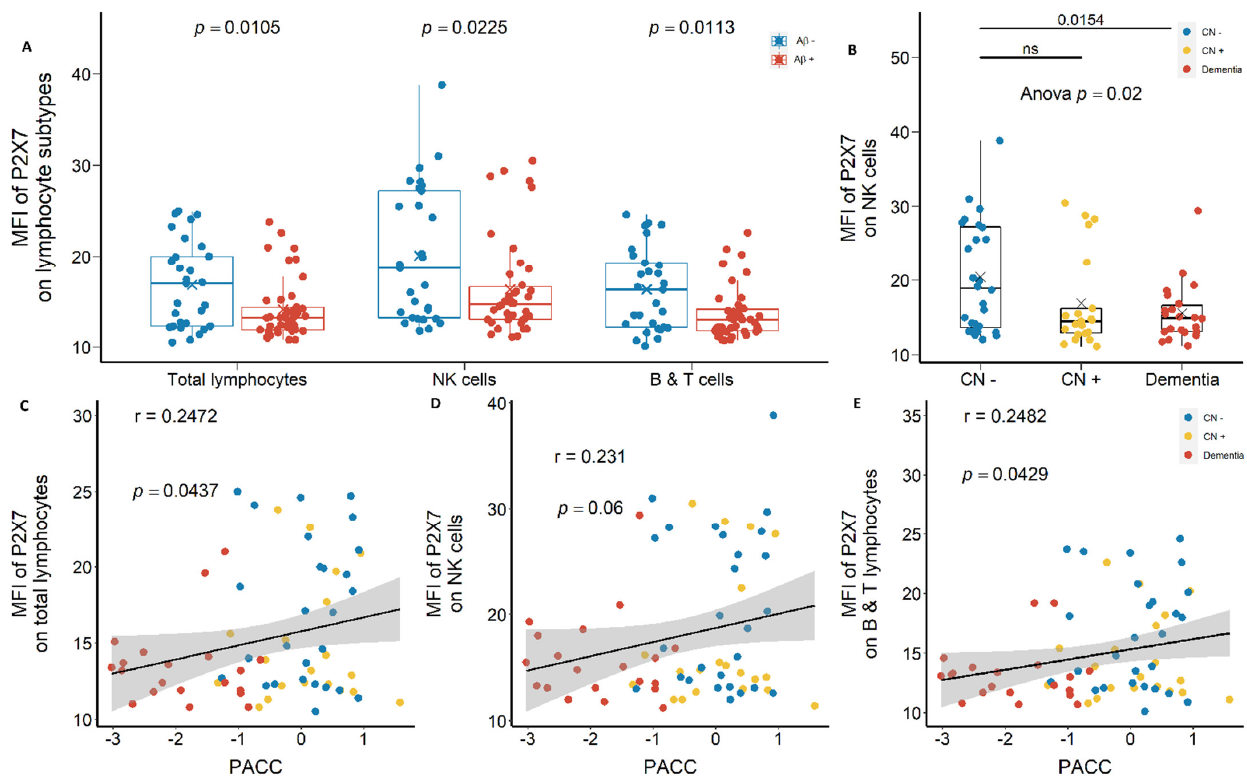
Figure 4. P2X7 expressions on lymphocytes in the discovery cohort. ( A ) P2X7 expressions on total lymphocytes ( left ), CD14 − CD16 + NK cells ( middle ), and CD14 − CD16 − B and T lymphocytes ( right ) between Aβ −ve (Aβ−) and Aβ +ve (Aβ+). Bar graphs illustrated the boxplot distribution of individual measurements with “x” denoting the mean. Two group comparison was determined by t -test. ( B ) P2X7 expressions on NK cells between CN (CN−: CN −ve), pre-clinical (CN+: CN +ve), and AD with dementia (Dementia: MCI +ve and AD) individuals. Bar graphs illustrated the boxplot distribution of individual measurements with “x” denoting the mean. Three-group comparison was determined by one-way ANOVA followed by multiple comparison using Dunnett’s post-hoc test (solid line). ( C – E ) The associations between P2X7 expressions and PACC. Correlation r and p values were calculated by Pearson product-moment correlational analysis. ns: no significance.